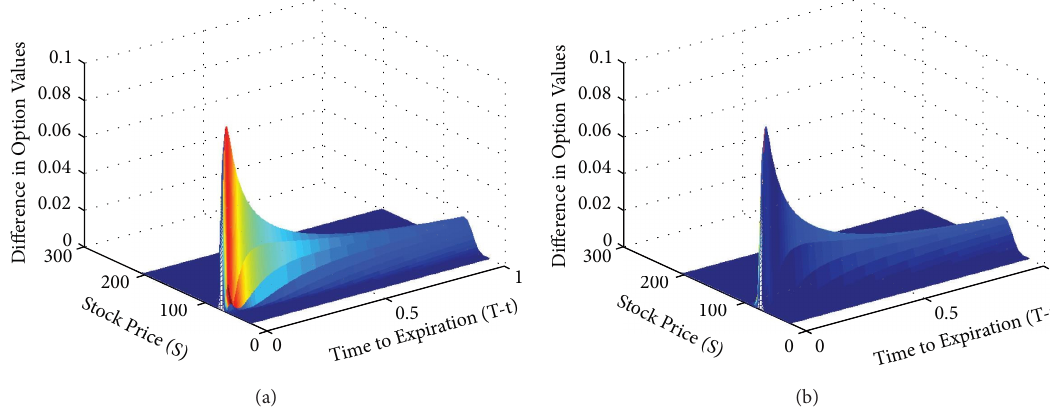
Figure 9: Here, we plot | V − V | of the linear Black-Scholes model. (a) One is for the Chebyshev spectral method, and (b) one is for Exact Numeric the differential quadrature